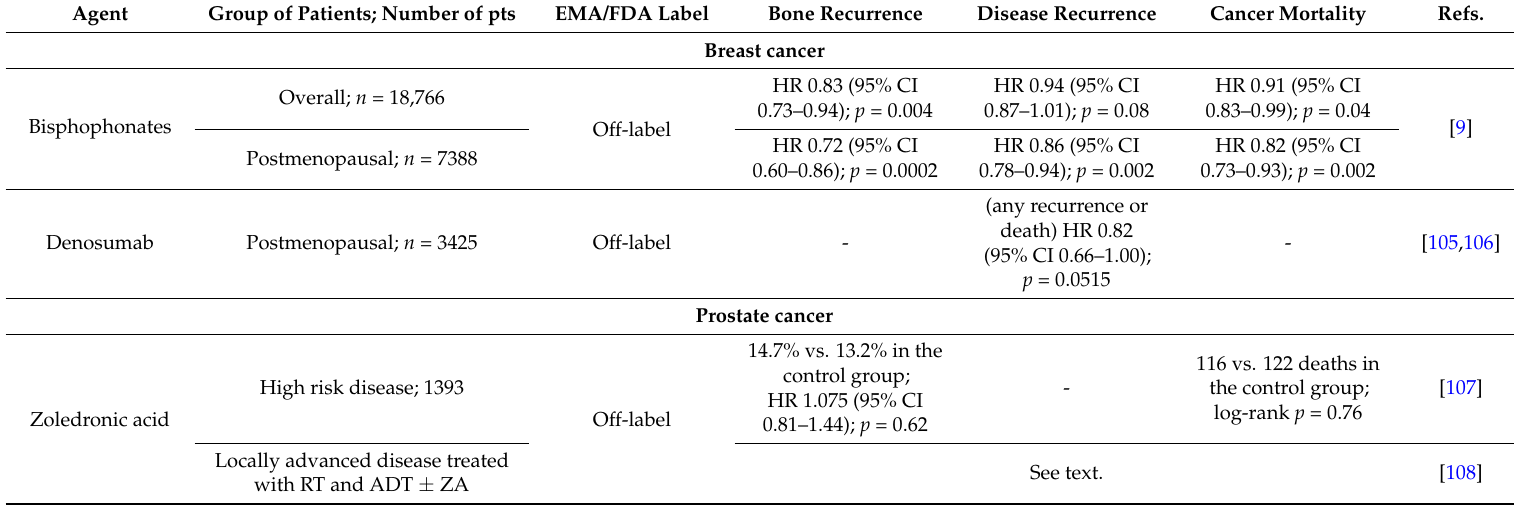
Table 2. Current data on the use of bone-targeted agents in the adjuvant treatment of breast and prostate cancers. ADT, androgen deprivation therapy; RT,